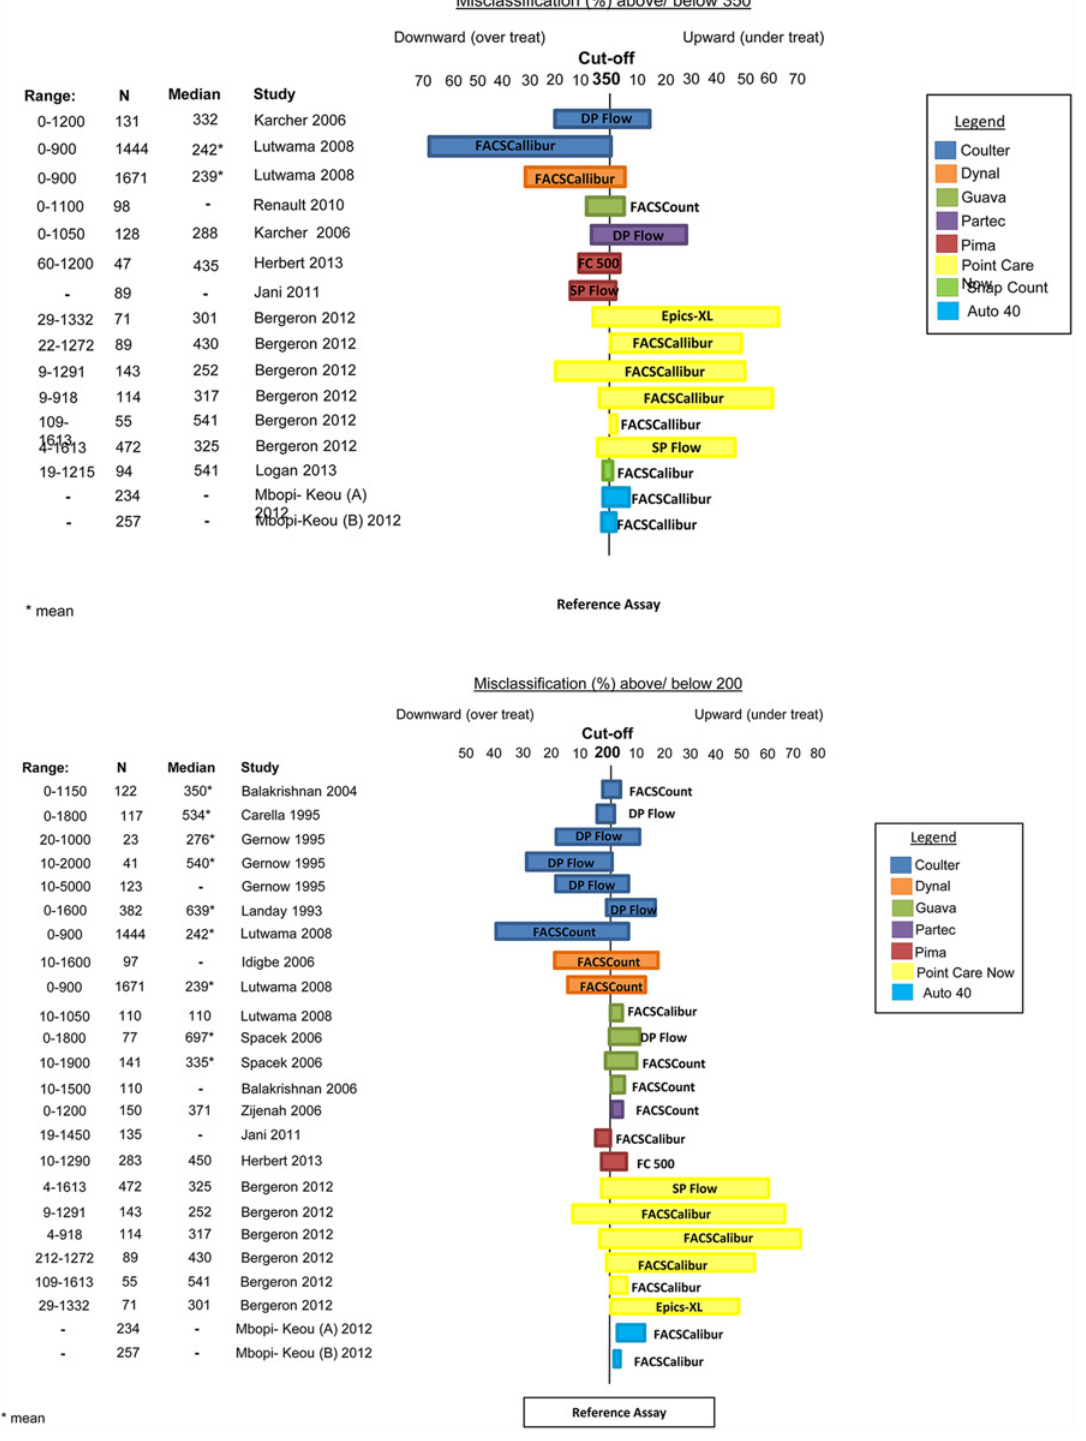
PLOS ONE | DOI:10.1371/journal.pone.0115019 March 19,